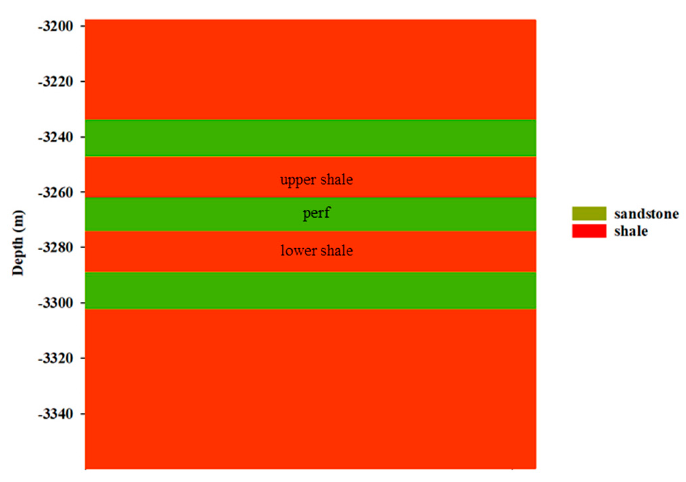
Figure 10. The profile of the multi-layer formation.